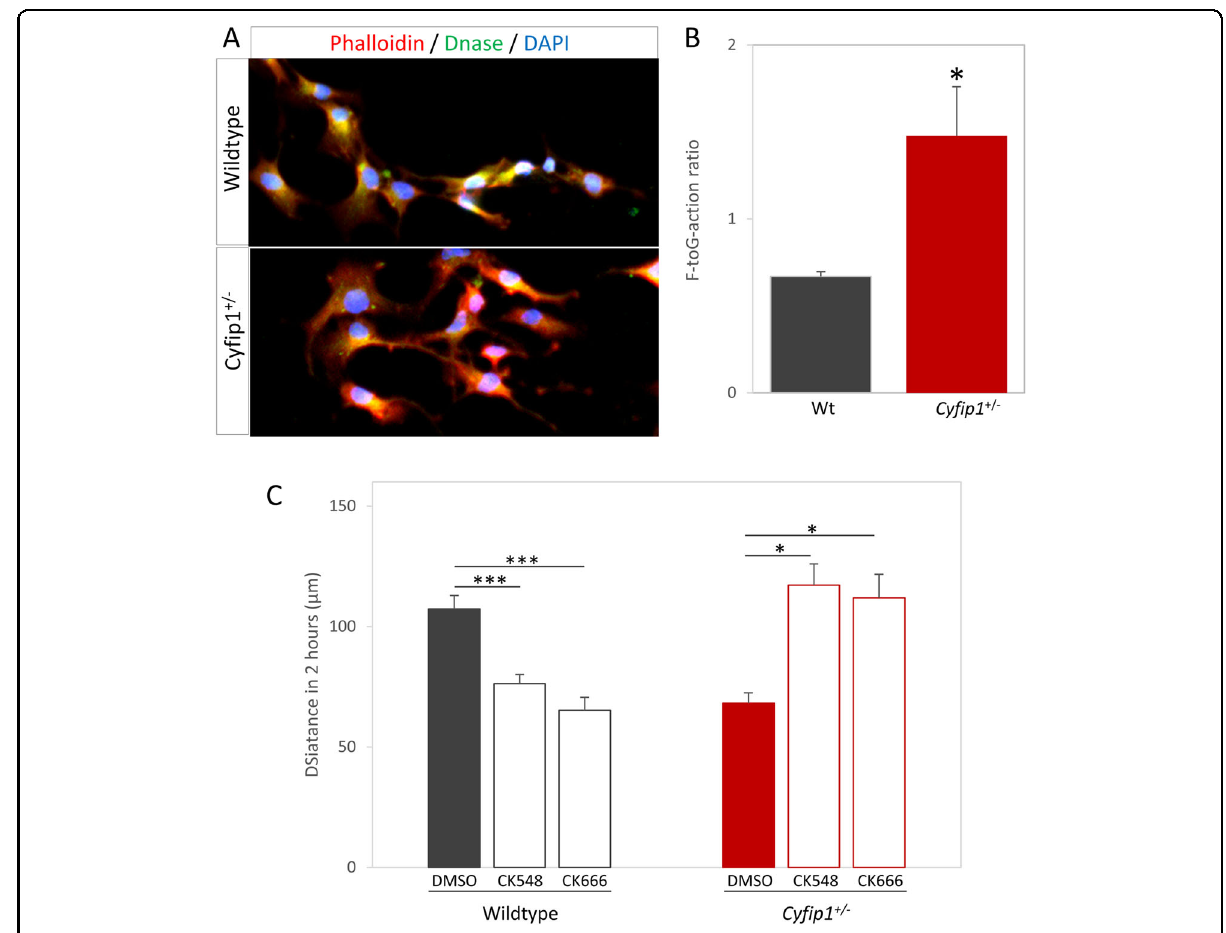
Fig. 5 Disruption of Arp2/3 mediated actin dynamics is responsible for migration de fi cit. A Fluorescently labelled phalloidin and DNAse show the amount of fi lamentous and globular actin, respectively. B Quanti fi cation of fl uorescence intensity shows Cy fi p1 + / − cells have an increased F- to G- actin ratio. C Treatment with Arp2/3 inhibitors CK-548 or CK-666 in wild-type cells signi fi cantly reduces the distance moved by cells during live imagine, whereas treatment of Cy fi p1 + / − cells restores distances to wild-type